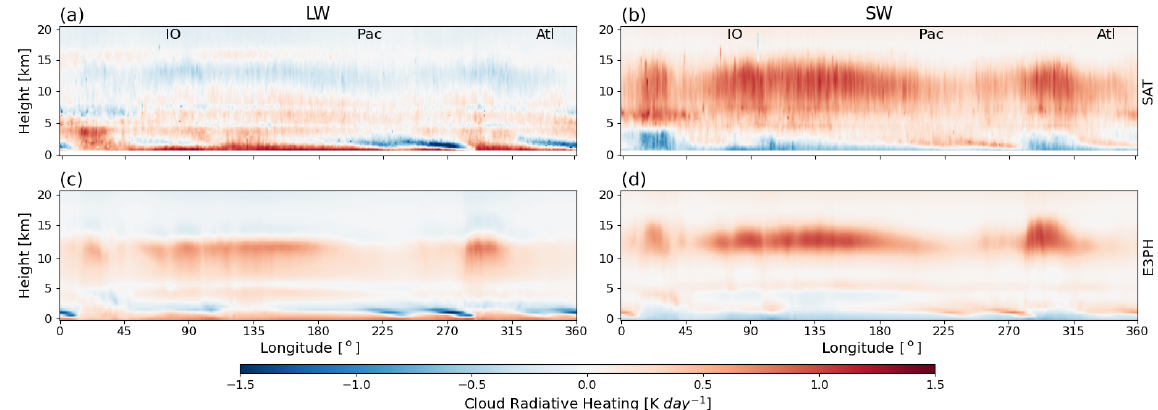
Figure 5. Longwave (LW) and shortwave (SW) cloud radiation heating averaged over all seasons for CloudSat/CALIPSO observations (SAT; a, b ) and high-resolution PRIMAVERA (E3PH; c, d ).